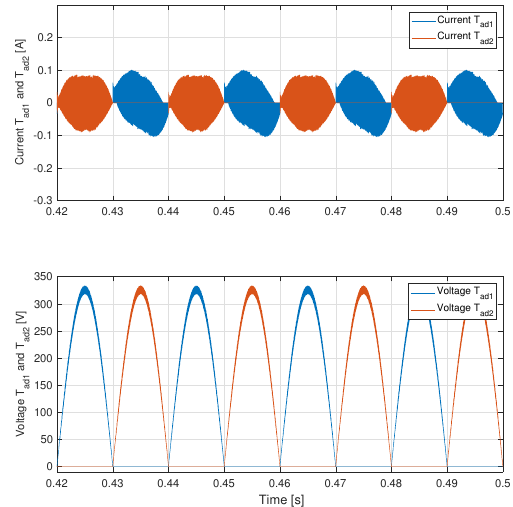
Figure 14. Current waveform ( top ) and voltage waveform ( bottom ) of the additional switches T ad 1 (blue trace) and T ad 2 (red trace).